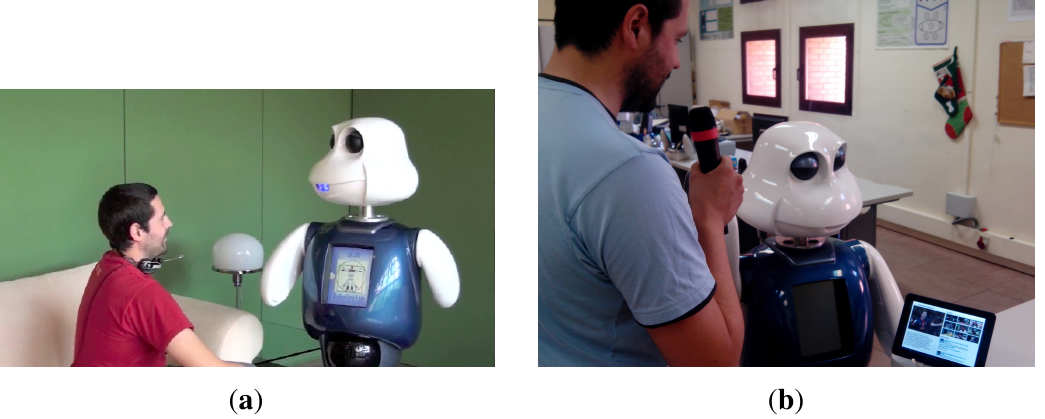
Figure 8. Human–robot dialog where the robot is showing information on a tablet about